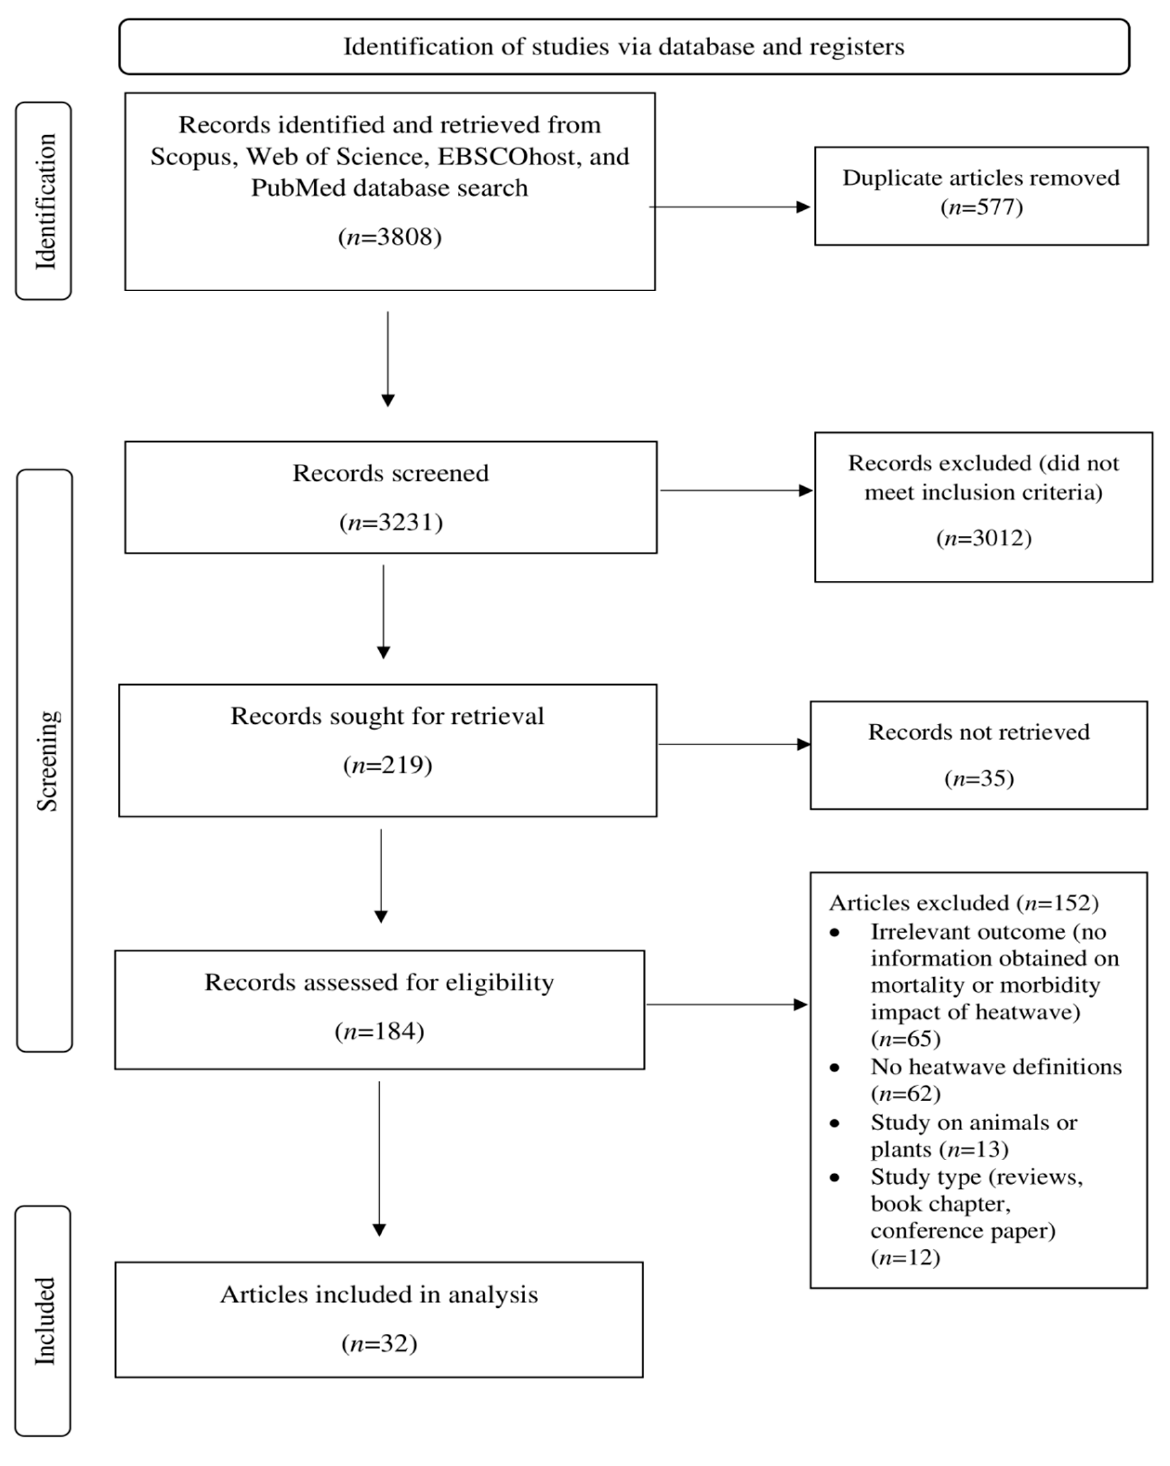
Figure 1. The PRISMA flow diagram.